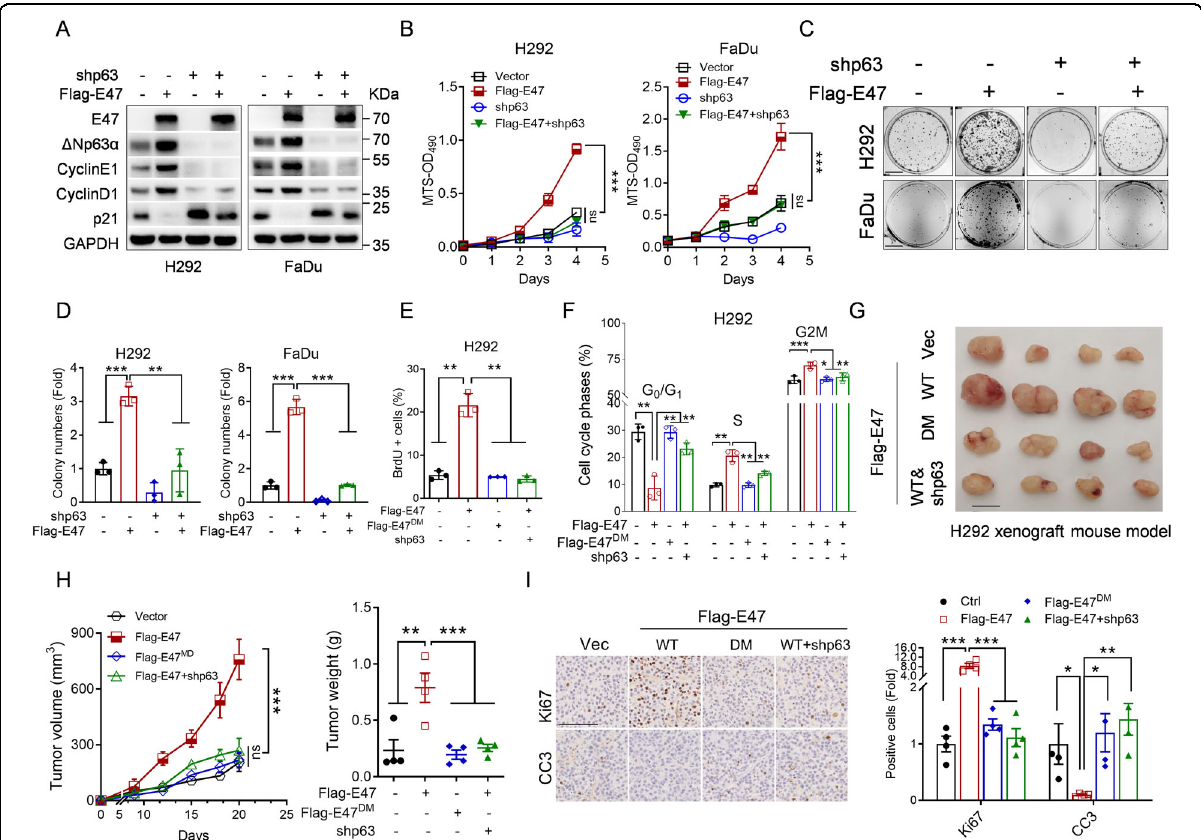
Fig. 2 Knockdown of Δ Np63 α blocks E47-mediated cell proliferation and tumor growth in vitro and in vivo. A – D H292 or FaDu cells stably expressing either Flag-E47 or shp63, or both were subjected to Western blot analyses ( A ), MTS assays ( B ), or Colony formation analyses ( C , D ). Scale bar = 1 cm. Three independent experiments were performed. Data were presented as mean ± SD. ** p < 0.01, *** p < 0.001. E , F H292 cells stably expressing either Flag-E47 (wild-type or DM mutant) or shp63, or both were subjected to BrdU or PI staining and FACS analyses. Three independent experiments were performed. Data were presented as mean ± SD. * p < 0.05, ** p < 0.01, *** p < 0.001. G , H H292 cells (1 × 10 6 ) stable cells were subcutaneously injected into BALB/C nude mice ( n = 4/group). Tumor sizes were measured every 2 – 3 days. Mice were euthanized by day 20 after inoculation and individual tumor weight was measured. Tumor photos, tumor volume, and tumor weight were presented. Scale bar = 1 cm. Data were presented as means ± SEM. ** p < 0.01, *** p < 0.001. I Tumors were fi xed, embedded in paraf fi n, sectioned, and IHC was performed for Ki67 and cleaved caspase-3 (CC3). Scale bar = 100 μ m. Data were presented as means ± SEM. * p < 0.05, ** p < 0.01, *** p <